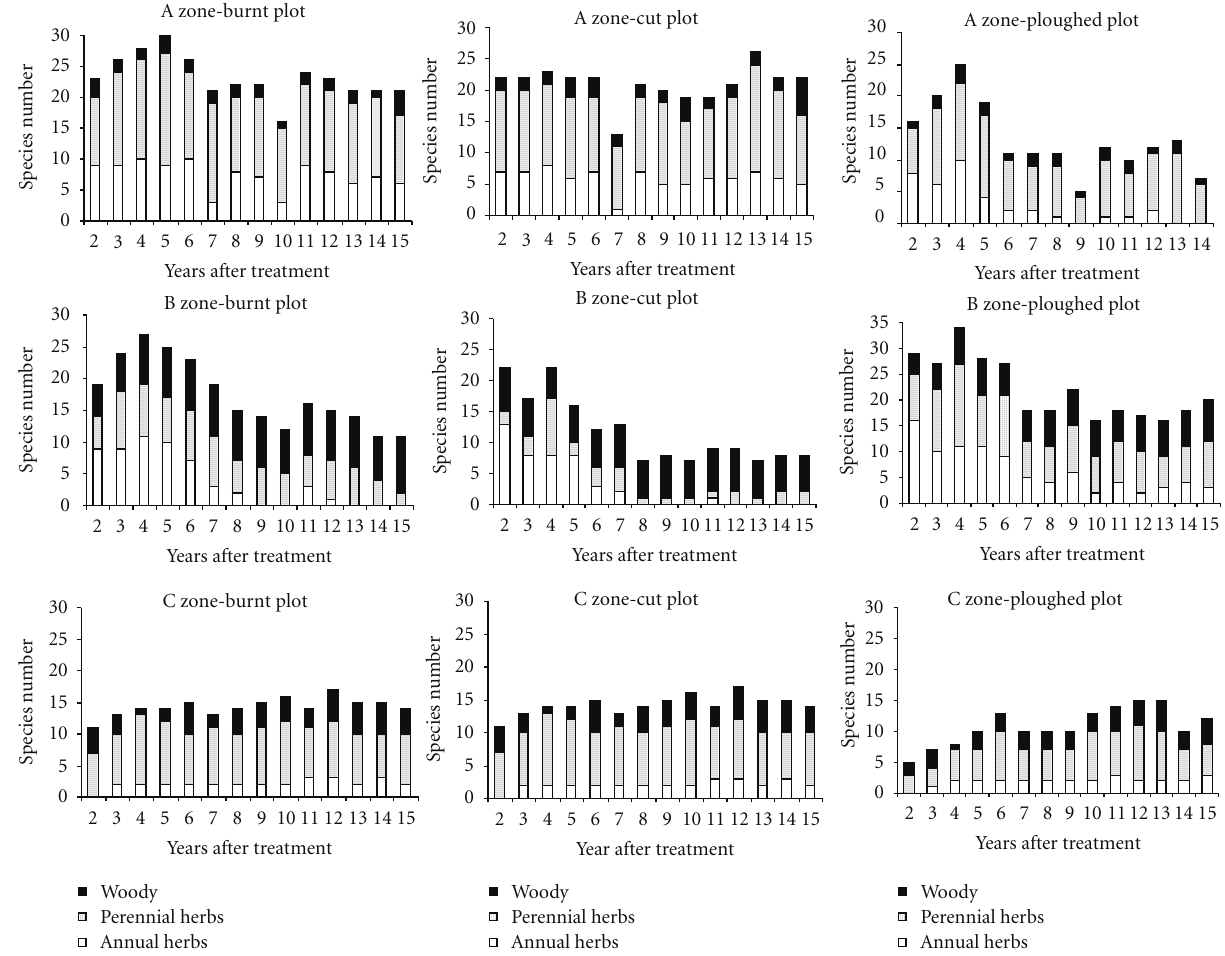
Figure 3: Changes in species richness ( S γ ) of life forms (woody, perennial herbaceous, annual herbaceous) after burning, cutting, and ploughing in the three zones (A, B, and C) during the study period (2 to 15